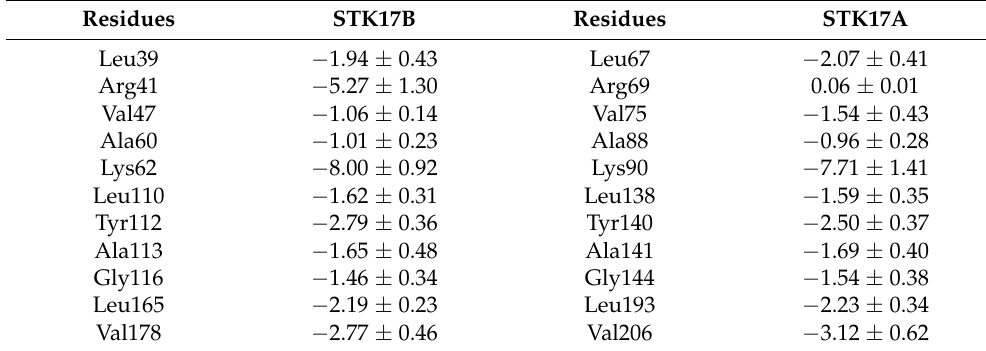
Table 2. Energy contributions (kcal/mol) of key residues to the binding free